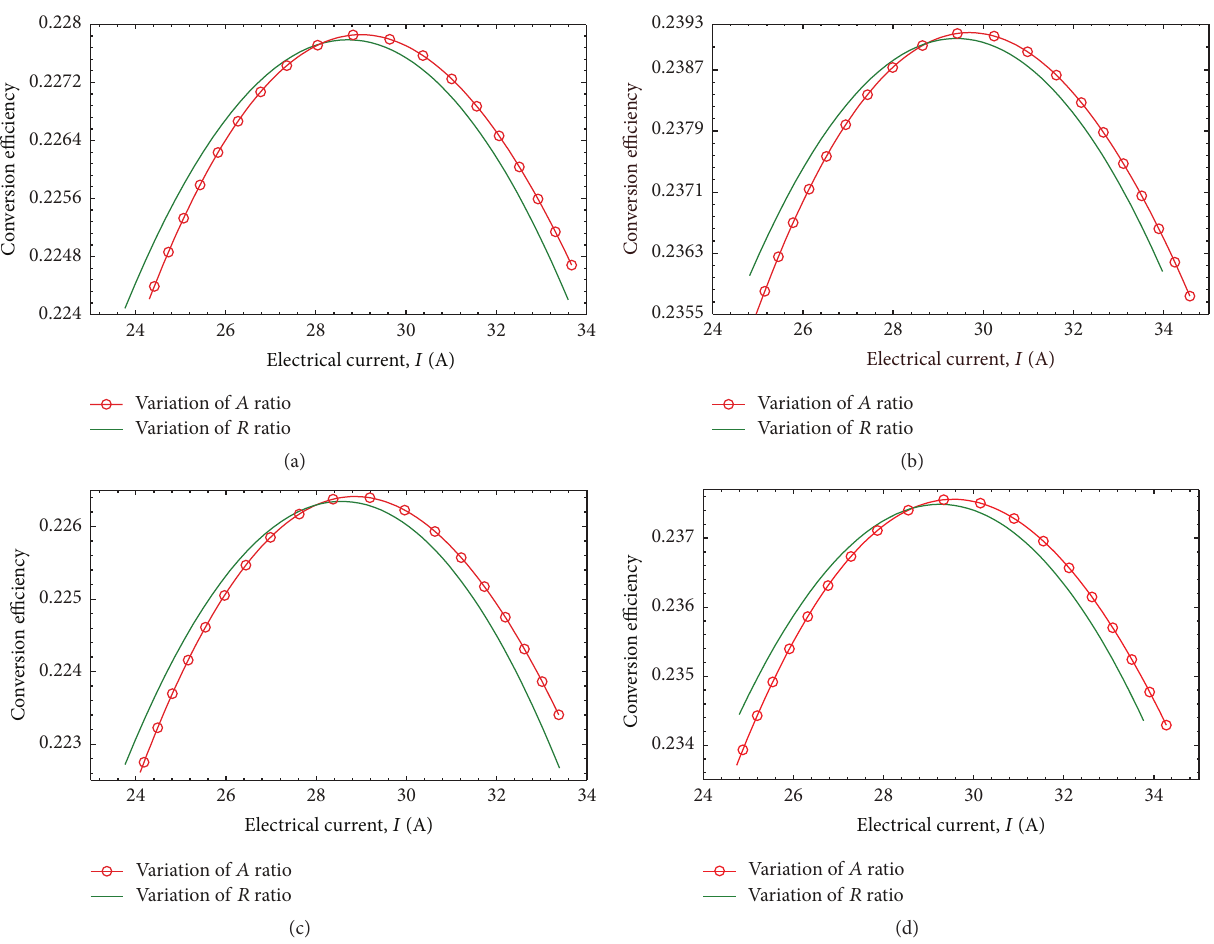
Figure 7: Variation of efficiency with respect to electrical current for the two following cases: constant 𝑅 𝐿 /𝑅 = 𝑜𝑝𝑡𝑖𝑚𝑢𝑚 V 𝑎𝑙𝑢𝑒 , variable /𝐴 𝑅 /𝑅 , constant 𝐴 /𝐴 = 𝑜𝑝𝑡𝑖𝑚𝑢𝑚 V 𝑎𝑙𝑢𝑒 . (a)–(d) represent 𝑝 1- 𝑛 1, 𝑝 1- 𝑛 2, 𝑝 2- 𝑛 1, and 𝑝 2- 𝑛 2 generators, 𝐴 𝑛 𝑝 , and variable 𝐿 𝑛 𝑝